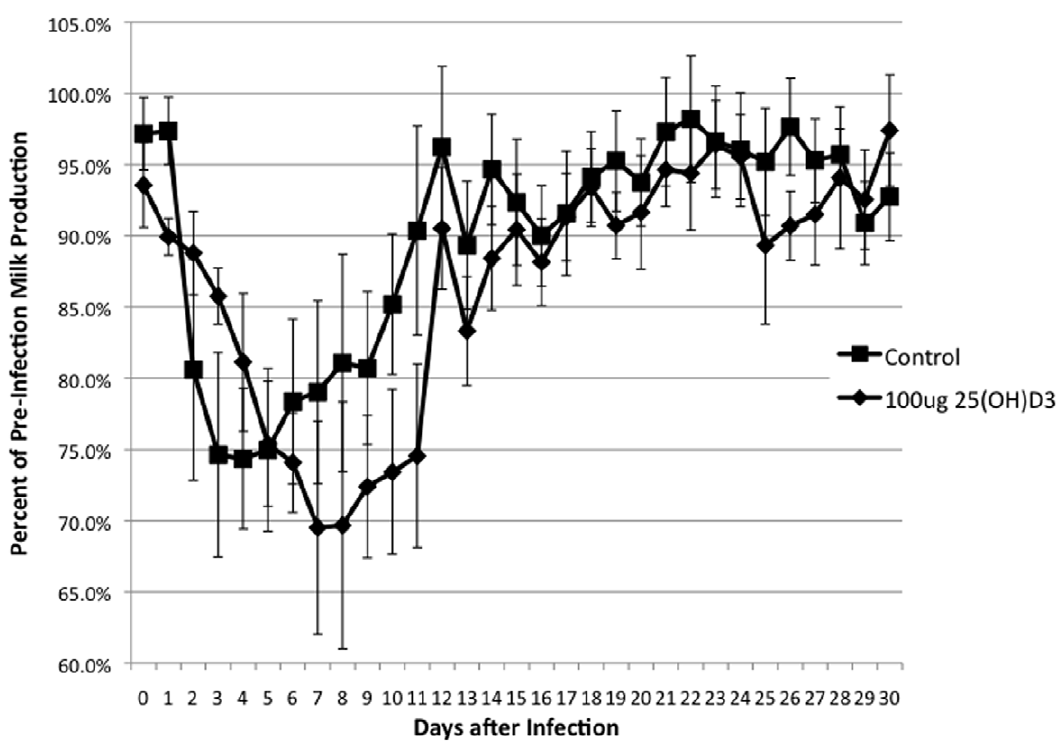
Figure 6. Milk Production in Control and 25(OH)D 3 Treated Animals. Daily milk production was determined for each cow. Data are expressed as a percentage of the pre-infections (the average of the 4 days milk production prior to infection). Each the average was determined for 25(OH)D 3 treated ( u ) and control animals( n ). Repeated measures analysis showed a significant treatment x time effect.